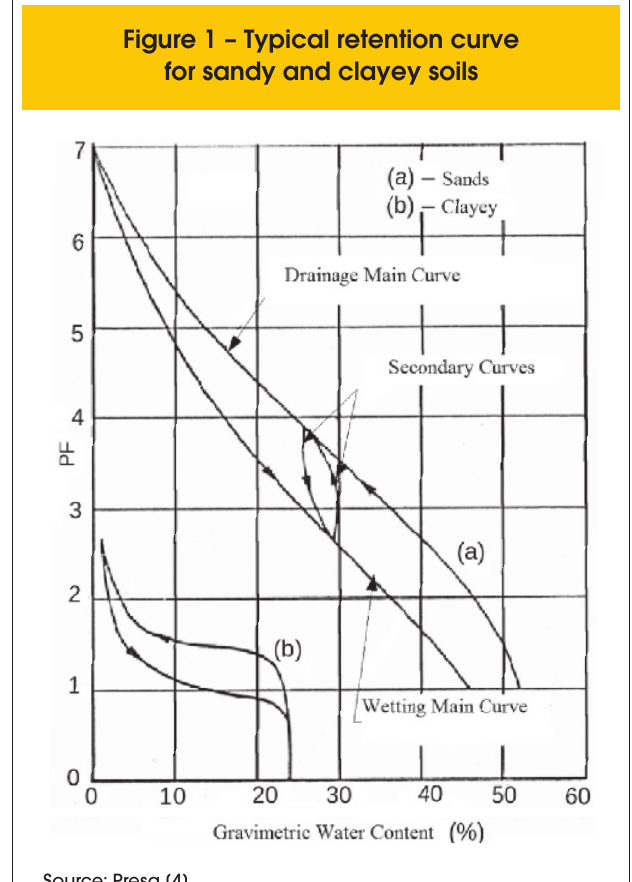
Figure 1 – Typical retention curve for sandy and clayey